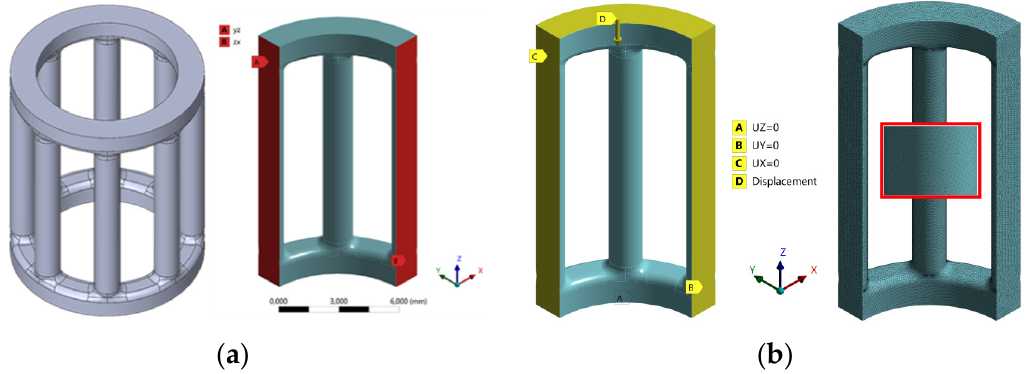
Figure 1. Simple column structure and boundary conditions: ( a ) column structure (left) for simulation using geometry regarding symmetry planes (right); ( b ) boundary conditions (left); meshed geometry (right).